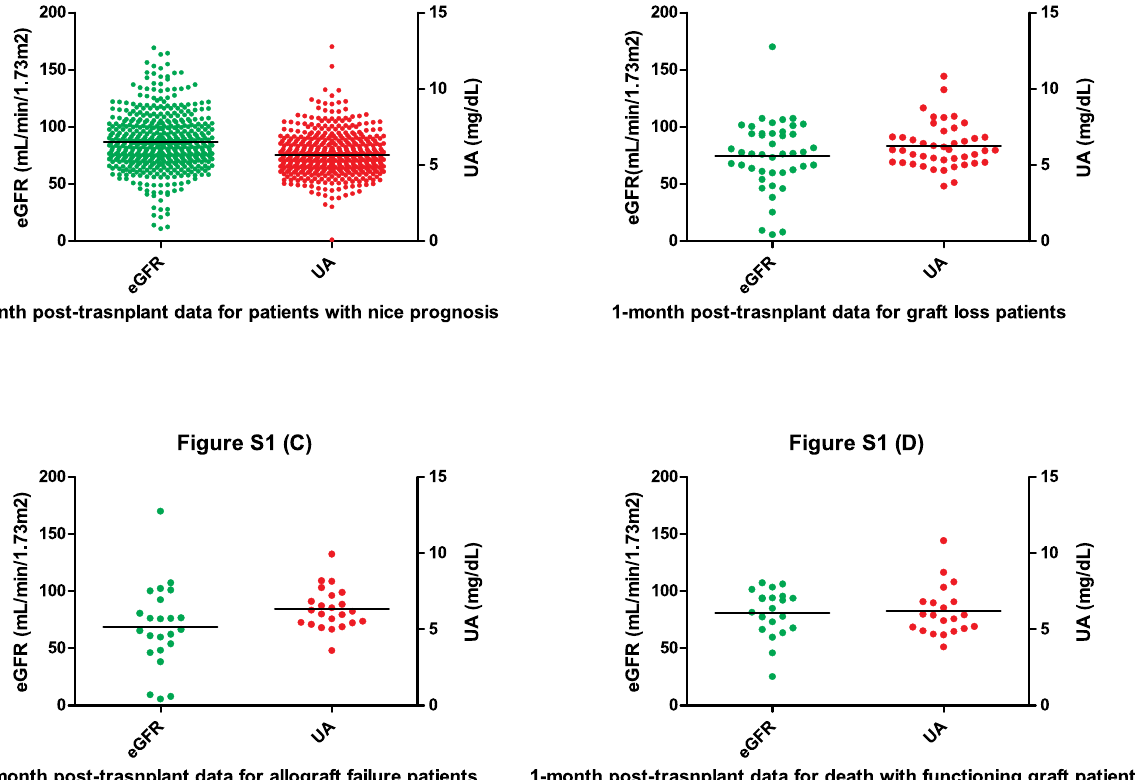
Fig 2. 1-month post-transplant eGFRs and UAs for patients of different outcomes. Every single dot represents for either an eGFR or a UA value. Green dots are plotted on left y axis and red dots are on right y axis. (A) It indicates the group of patients without bad outcomes. (B) Patients suffered allograft failure or dead eventually. (C) Patients only suffered allograft failure. (D) Patients dead with functioning